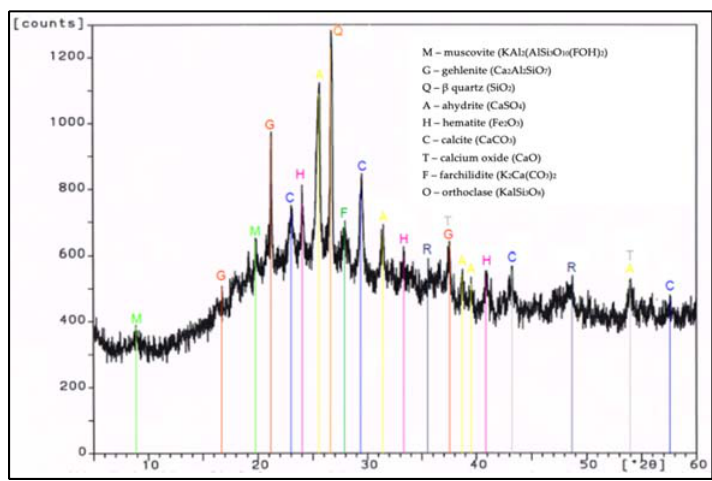
Figure 2. XRD pattern of fluidized bed combustion fly ash (FBC).